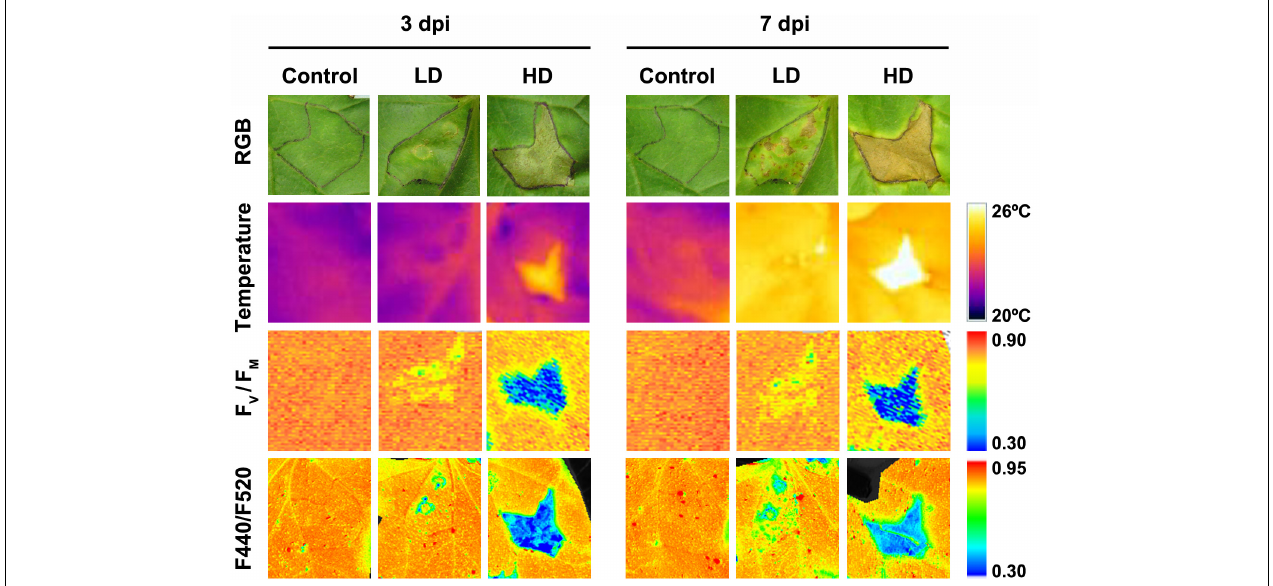
FIGURE 1 | Evolution of symptoms caused by Dickeya dadantii in melon leaves inoculated at LD or HD (low and high dose, 10 4 and 10 6 colony forming units ml − 1 , respectively). The same mock-control and bacteria infiltrated areas are displayed for the RGB and leaf temperature images, as well as for the images calculated for F V /F M and F440/F520 ratio. The corresponding color scale for each parameter is shown. F V /F M , maximum quantum efficiency of photosystem II; F440/F520, blue over green fluorescence; dpi, days